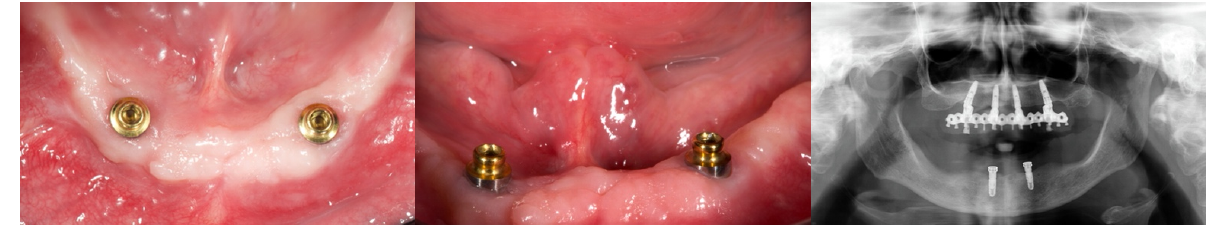
Figure 1. Explanatory case (test group).